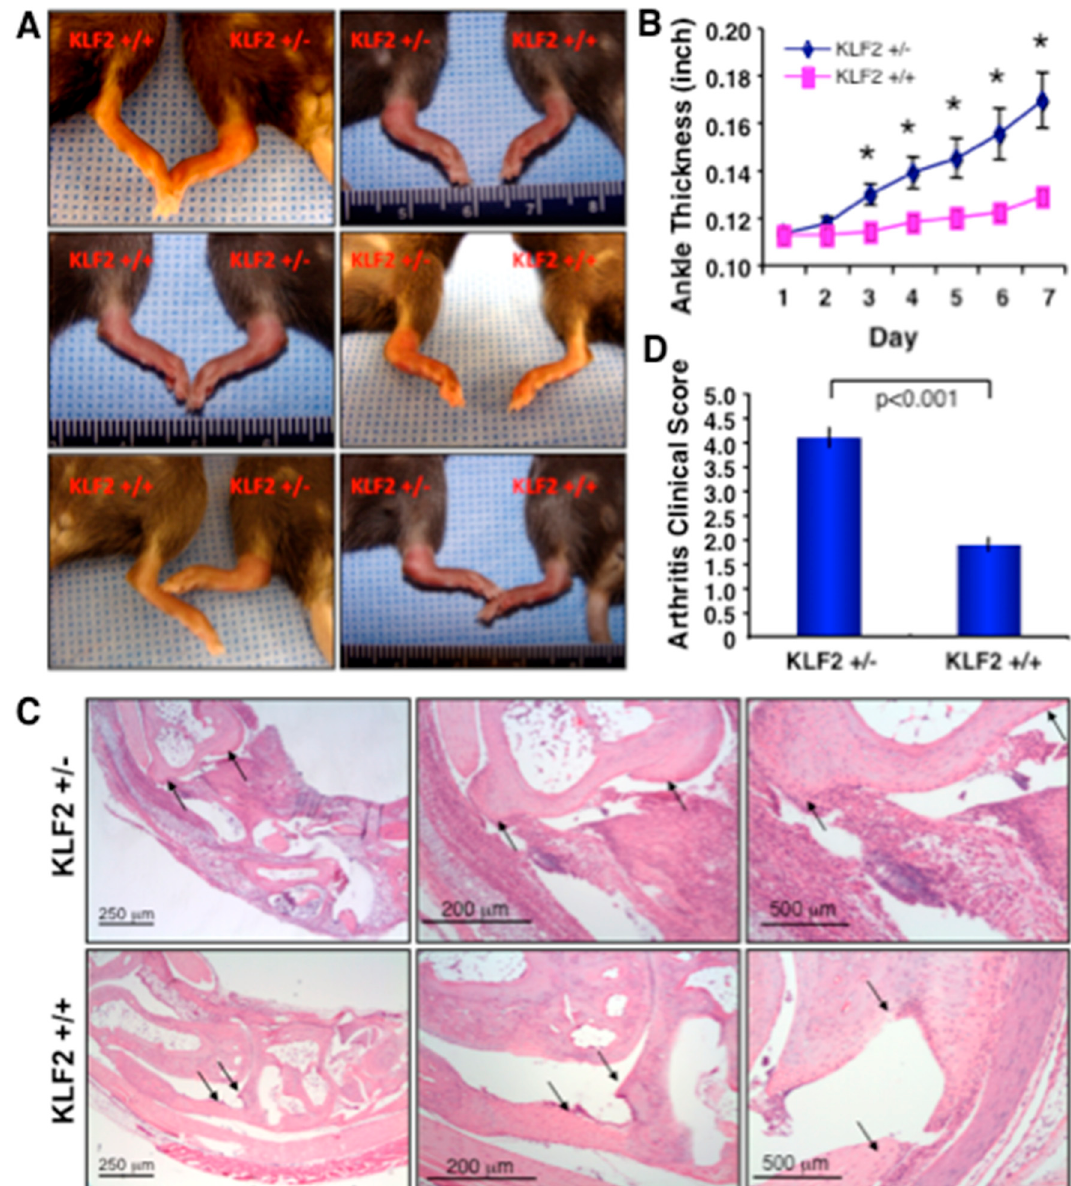
Figure 1. K / BxN serum-induced arthritic pathogenesis was elevated in Krüppel-like factor 2 (KLF2) hemizygous mice. ( A ) Acute arthritis was induced in KLF2 +/ − and KLF2 +/+ mice (C57BL / 6 background) using K / BxN serum and inflammation and severity of pathogenesis in morphology were assessed.